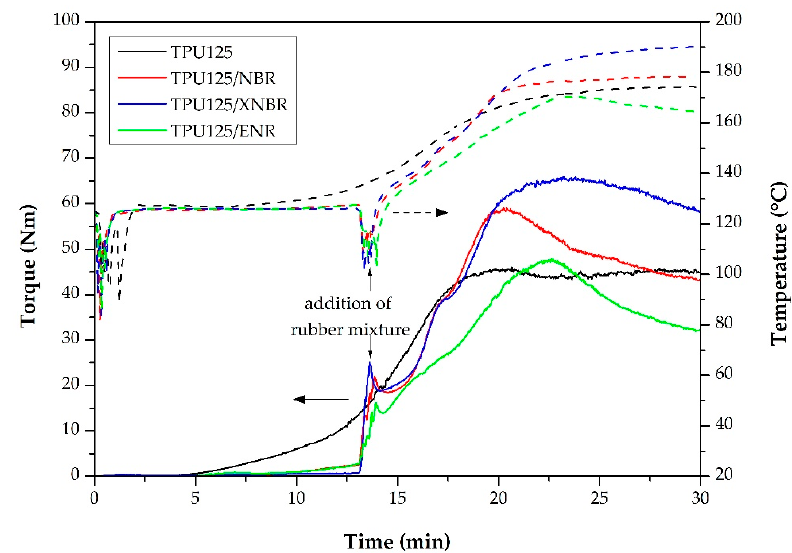
Figure 4. The parameters recorded during the synthesis of the thermoplastic dynamic vulcanizates (TDVs): torque curves (——) and temperature curves (– – –).